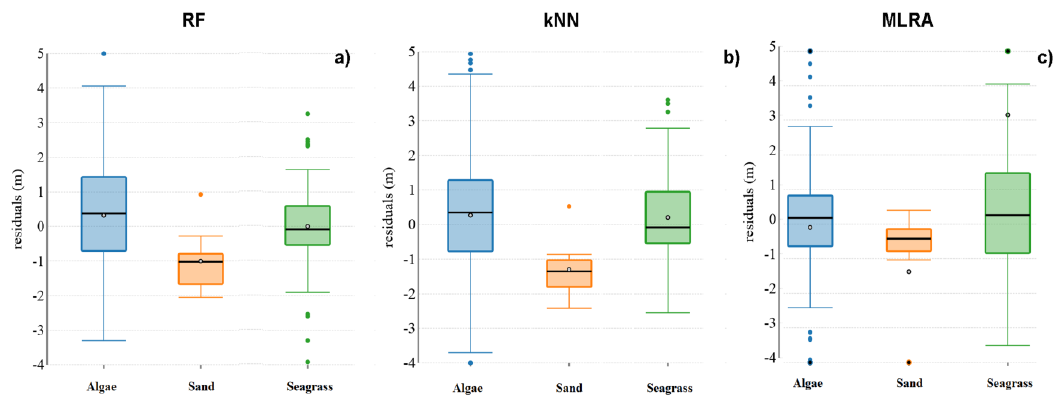
Figure 5. Box-plots of seafloor-type classes and bathymetry residuals from each resulting satellite- derived bathymetry (SDB) using (a) RF, (b) kNN, and (c) MLRA. Seafloor types available only for PR2 [27].